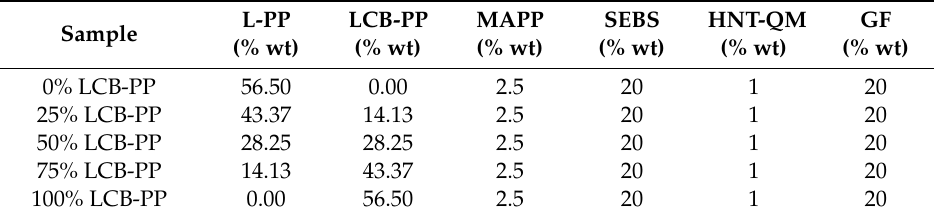
Table 1. Nomenclature and chemical composition of the considered